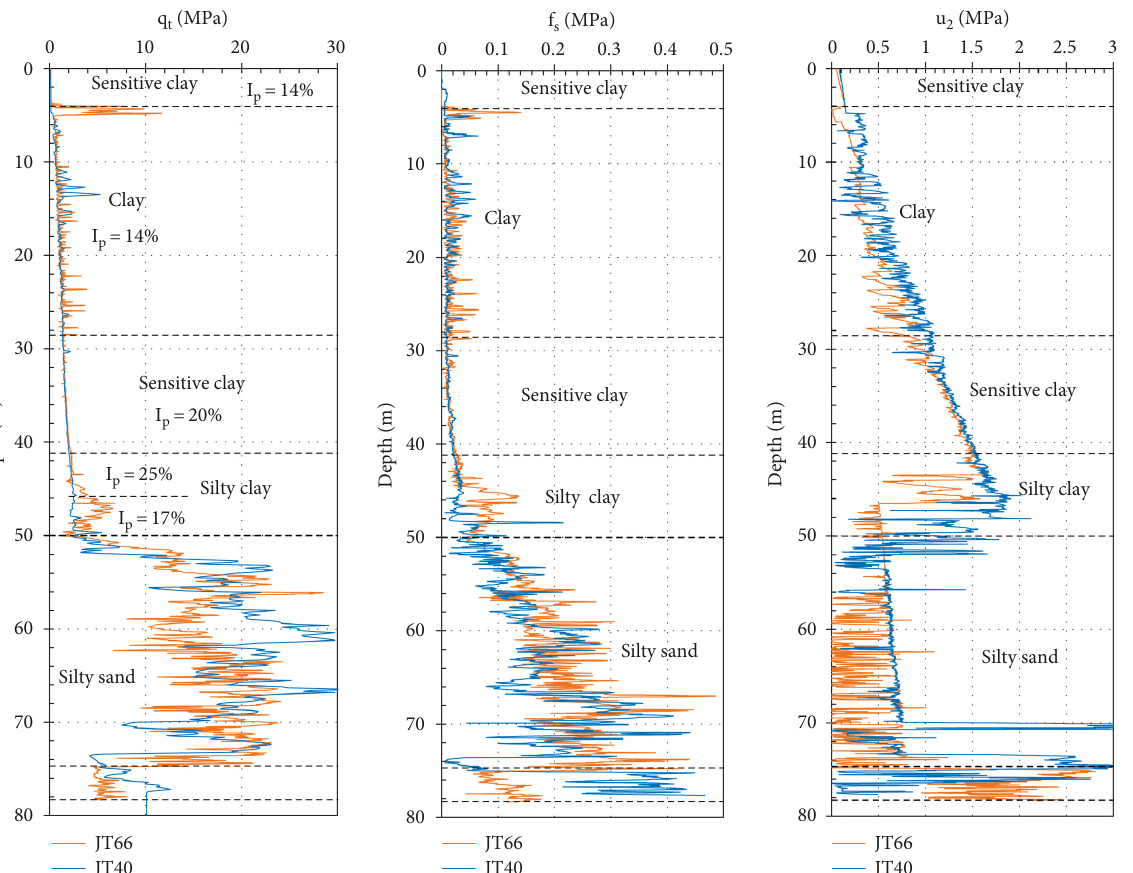
Figure 8: Cone penetration test